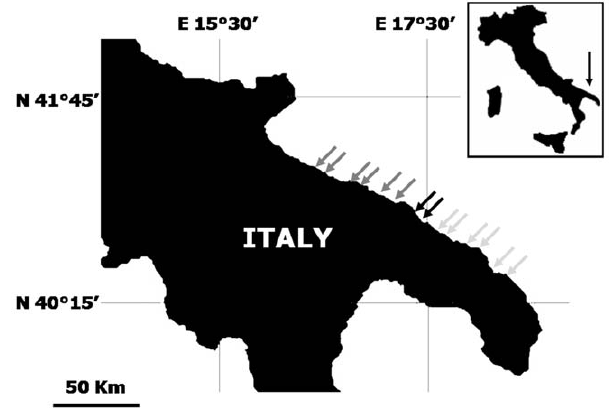
Figure 1. Study area. Arrows indicate the sampling sites. Black arrows indicate sites within TGMPA, dark grey arrows indicate sites north of TGMPA borders and light grey arrows indicate sites south of TGMPA borders. See Table 1 for name and coordinates of the sampling sites.